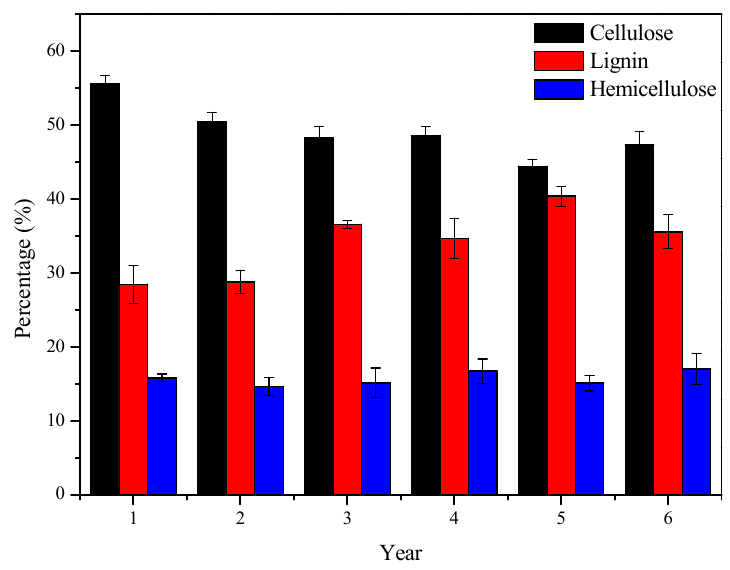
Figure 1. 1–6 years old bamboo composition analysis.